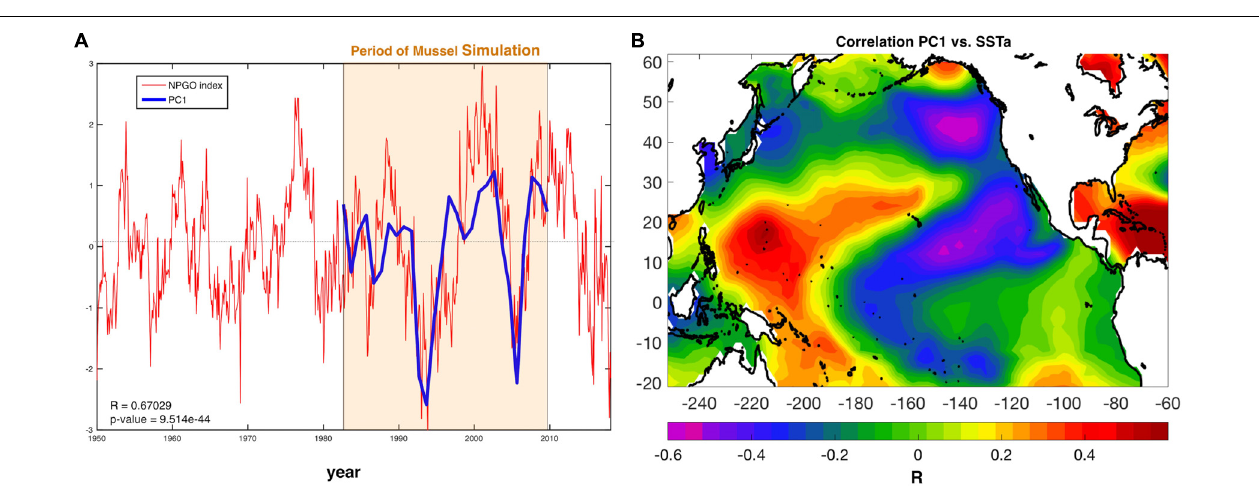
FIGURE 4 | (A) NPGO index (red) for the entire available record and PC1 of mussel production (blue). (B) Correlation between PC1 and Pacific sea surface temperature anomalies (SSTa) reveals a large-scale climate pattern resembling the North Pacific Gyre Oscillation